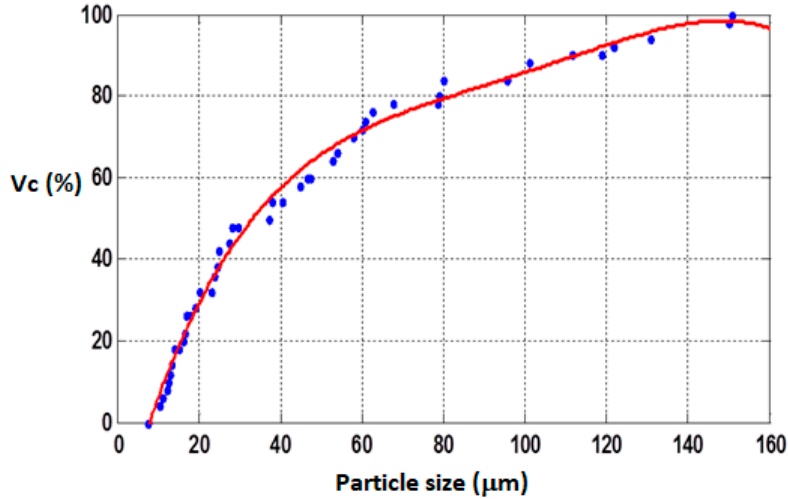
Figure 1. Iron particle distribution within the matrices. 103